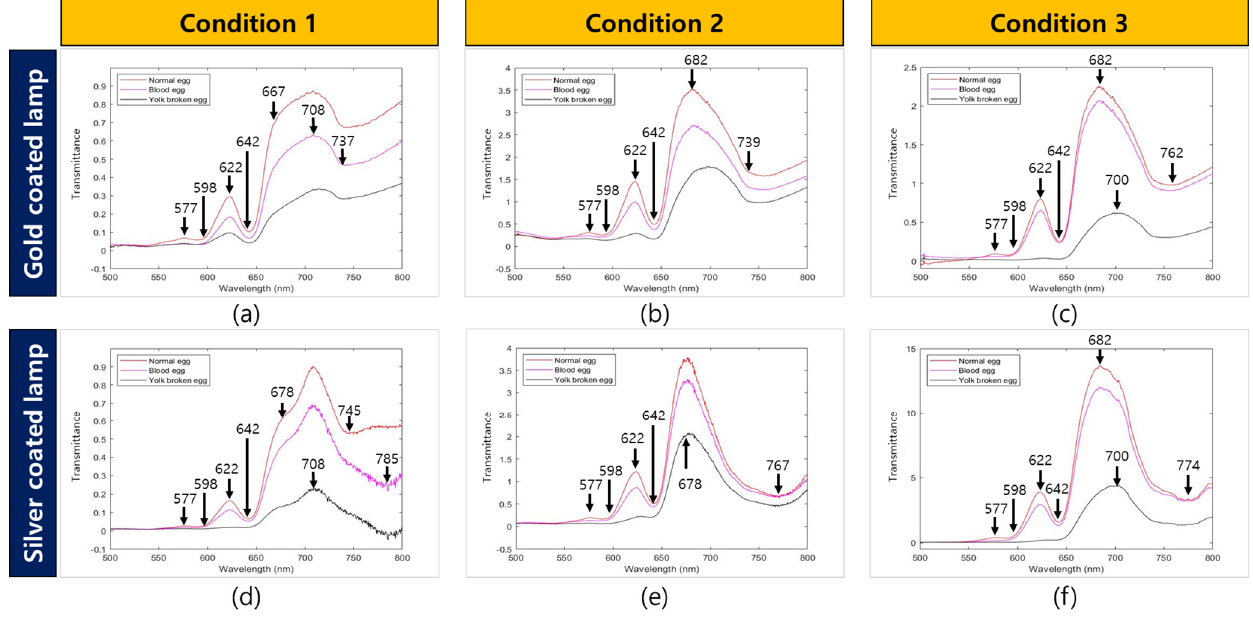
Figure 7. Abnormal egg and normal egg mean spectrum according to various light test conditions. ( a ) Gold − coated condition 1 mean spectrum; ( b ) gold − coated condition 2 mean spectrum; ( c ) gold − coated condition 3 mean spectrum; ( d ) silver − coated condition 1 mean spectrum; (e) silver − coated condition 2 mean spectrum; ( f ) silver − coated condition 3 mean spectrum.